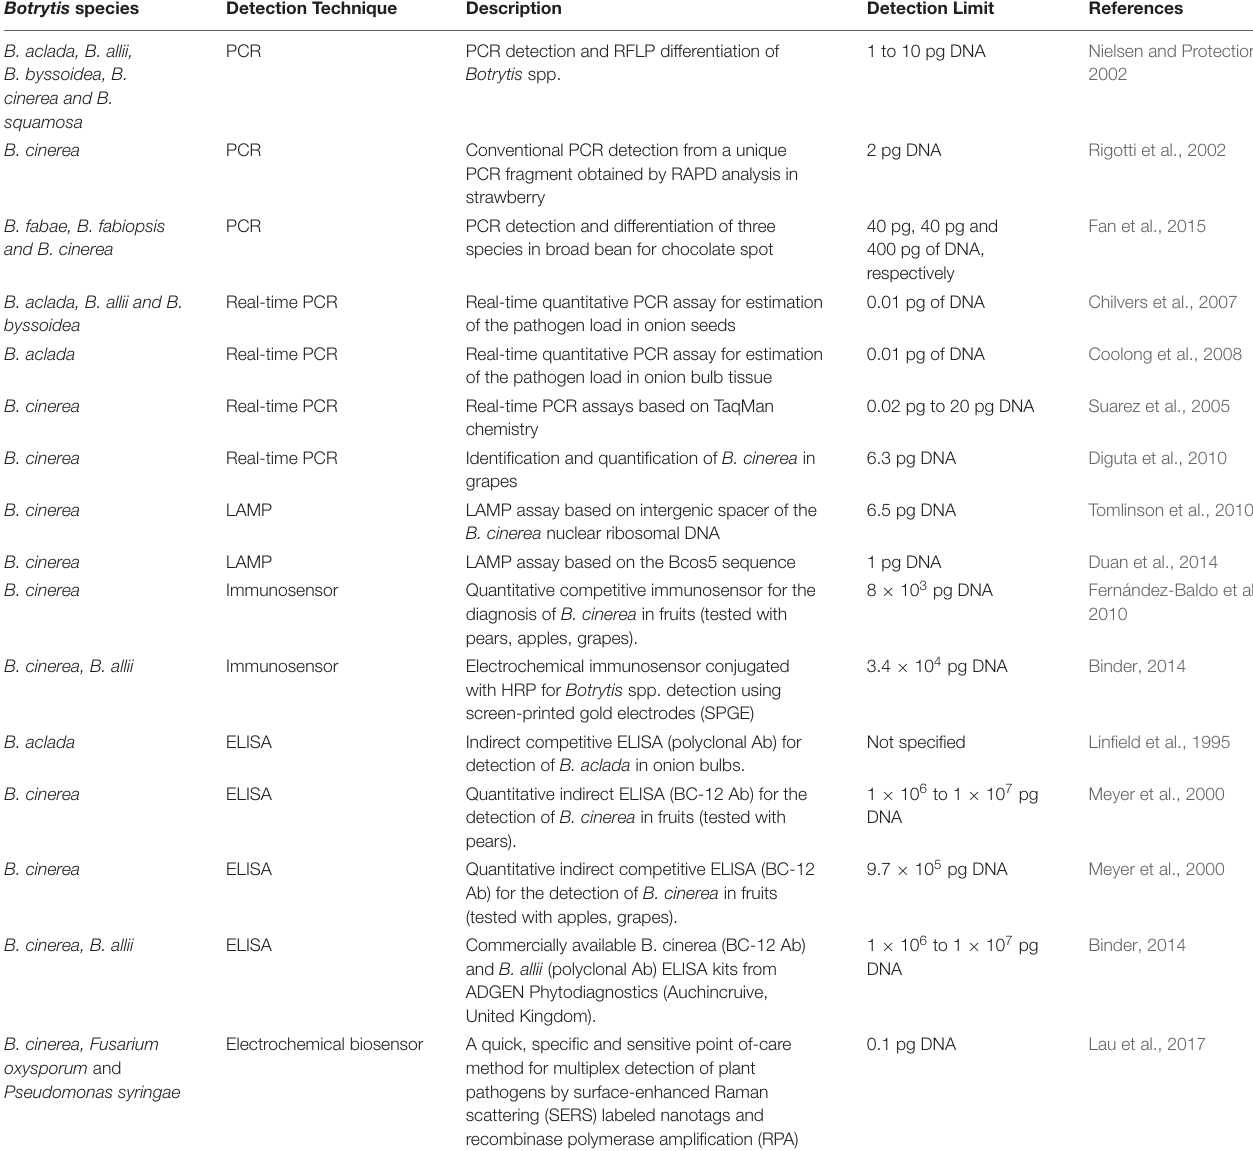
TABLE 1 | Summary of published diagnostic methods and their detection limits for crop disease-related Botrytis species. Botrytis